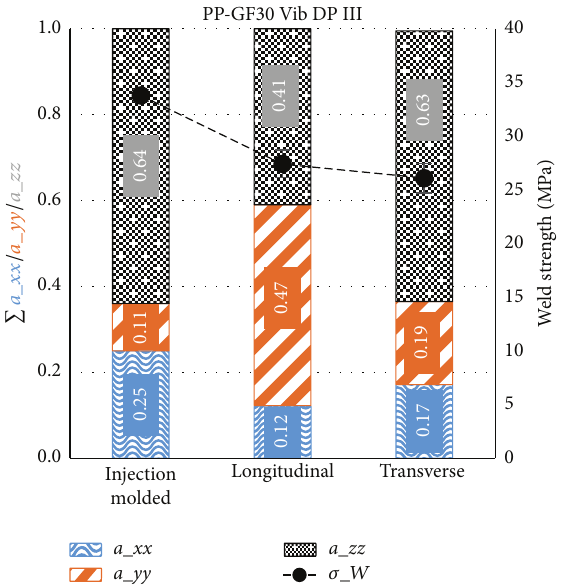
Figure 29: Fiber orientation and weld strength in vibration welding of PP-LGF30 for different initial fiber orientations.